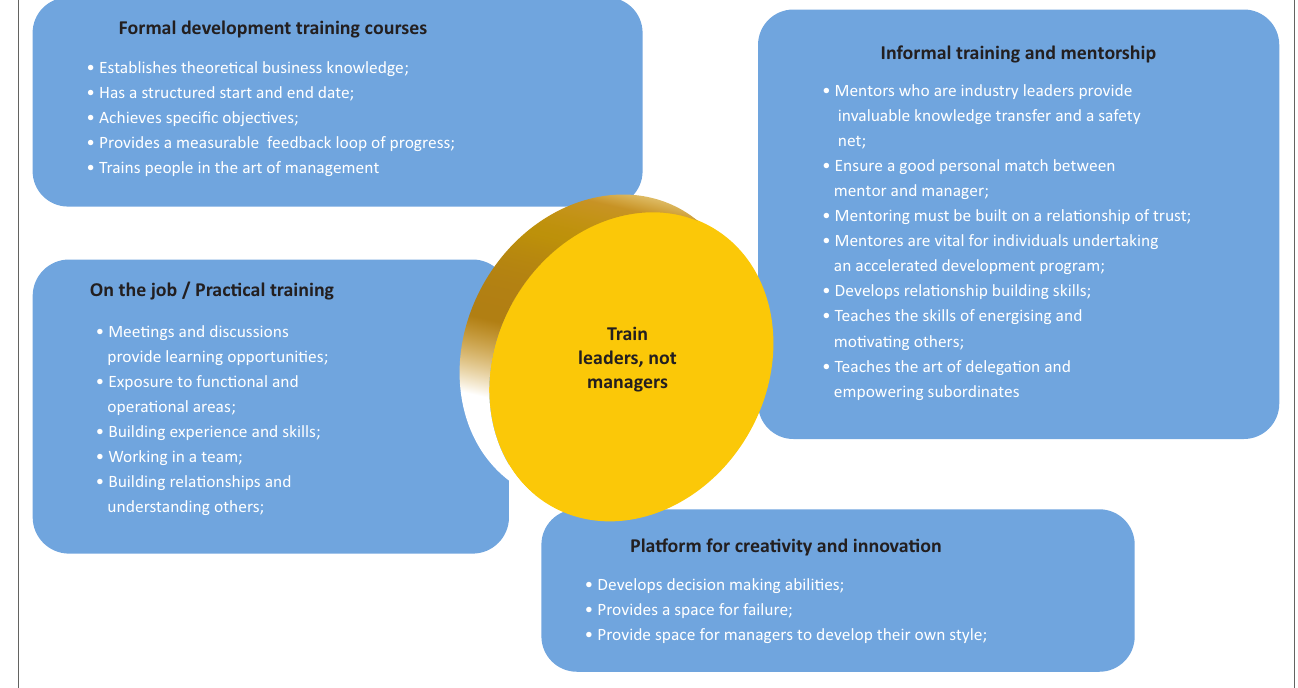
FIGURE 4: Consolidated leadership